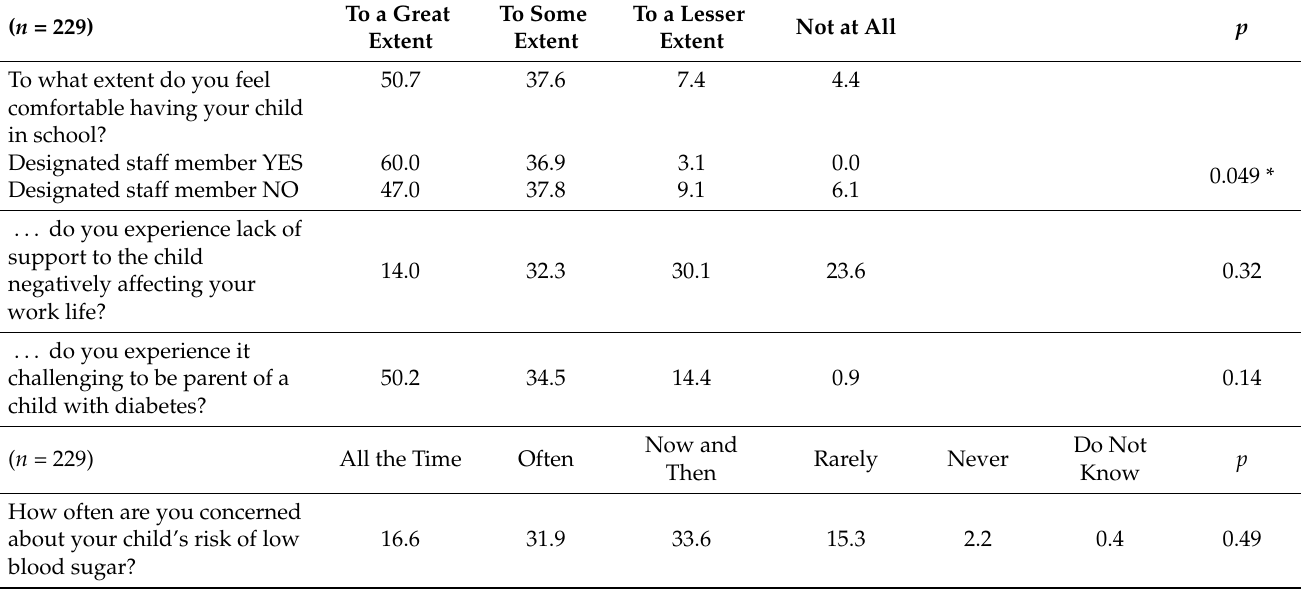
Table 6. A selection of questions and answers within the theme: Being a parent of a child with type 1 diabetes. All questions are worded with emphasis on the time prior to the COVID-19 pandemic. The answers are presented in total frequencies (%) and significant associations ( p < 0.05), stratified for status for designated staff member (YES/NO), are also